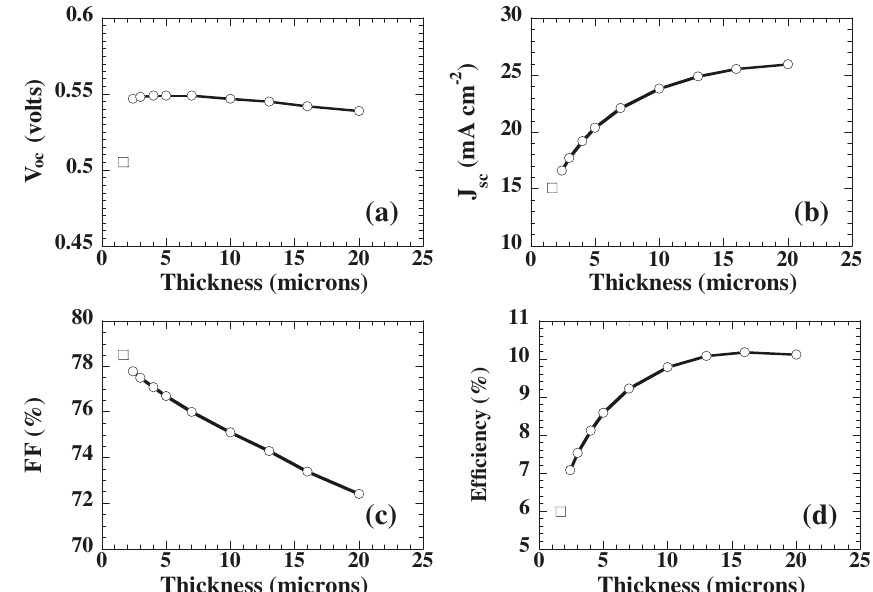
Fig. 6. The solar cell output as a function of the thickness of the epitaxial silicon layer. The sharp fall in V oc of the 1.7 micron cell is due to the fact that modelling of this cell’s J - V and EQE characteristics indicate that it has a more disordered interface layer at the epi-Si/P-c-Si interface than is present in the 2.4 micron cell. Therefore a different symbol is used for this case. The thicker cells have been assumed to have the same parameters as the 2.4 micron